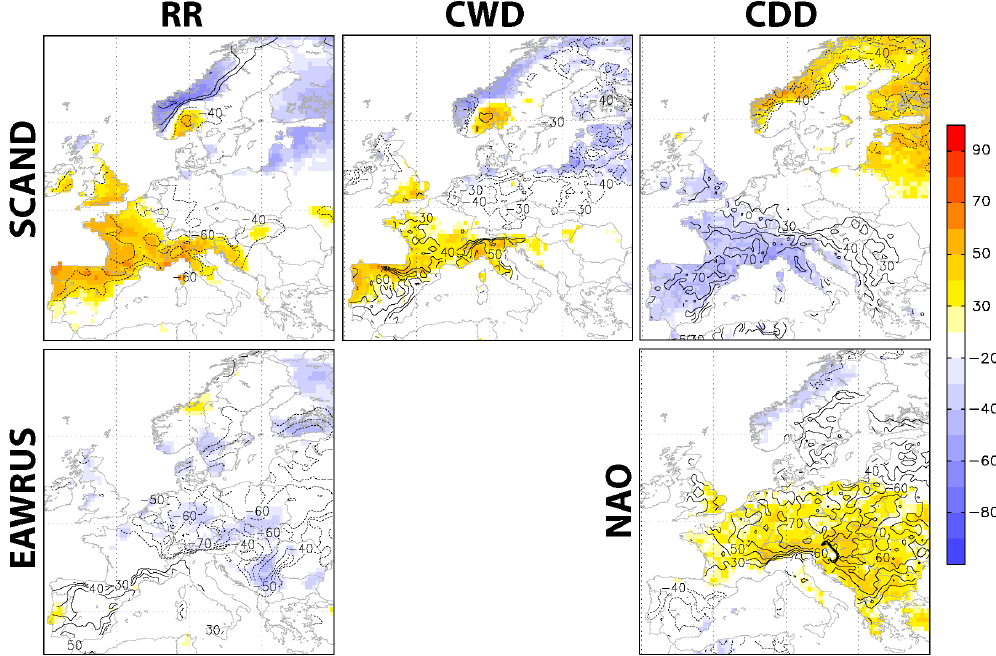
Fig. 10. Shaded regions represent the correlation coefficients ( × 100) between the teleconnection indices (SCAND, EAWRUS, NAO, by rows) and the mean or extreme precipitation fields (by columns) in autumn. Contour lines represent the EOF associated with the PC better correlated with the teleconnection index according to Table 5.